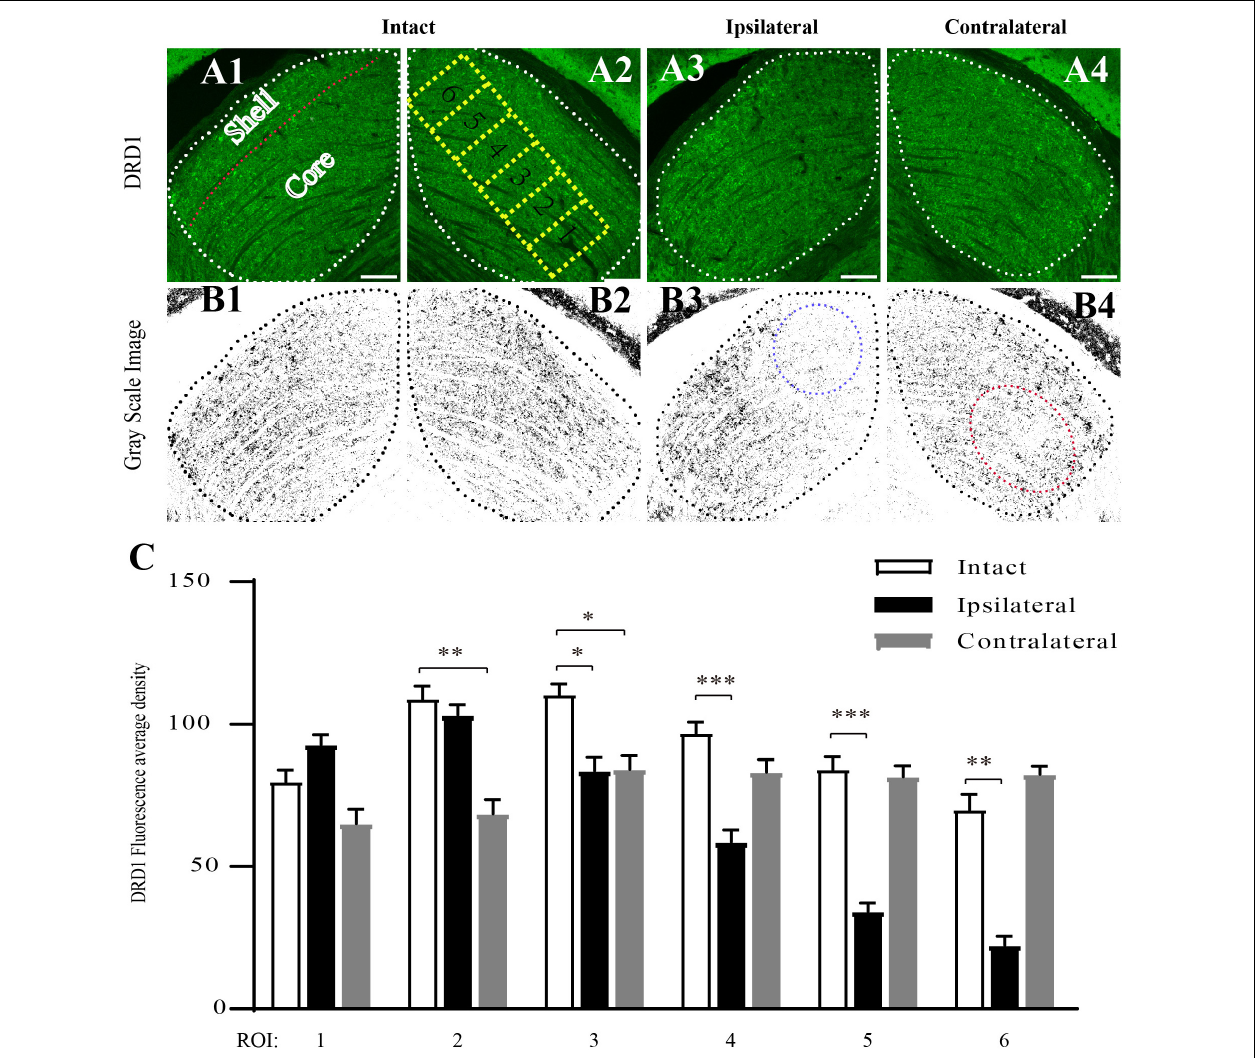
FIGURE 5 | Downregulation of DRD1 in dLGNs in the target regions of mouse amblyopic eyes. (A1–A4) Anti-DRD1 immunostaining in the dLGN. The dashed white line delineates the dLGN. The shell and core regions are separated with a dashed red line in (A1) . Six ROIs (region of interest) in (A2) represent the areas for measuring and statistics. (B1–B4) Grayscale image of anti-DRD1 immunostaining for statistics. The most downregulated areas are indicated with a dashed blue circle in (B3) and a dashed red circle in (B4) . (C) Quantification of the normalized fluorescence intensity of DRD1 staining. Data represent the mean ± SE, n = 8 for the intact group, n = 6 for both ipsilateral and contralateral groups, * p < 0.05, ** p < 0.01, *** p <